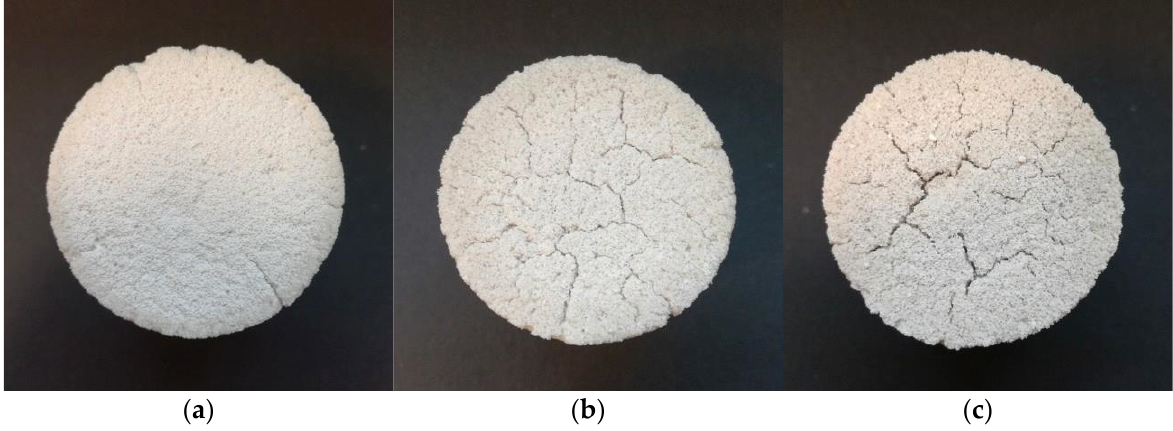
Figure 9. Effect of slag addition (( a ) 10, ( b ) 30 and ( c ) 50 wt%) on the shrinkage of foams.